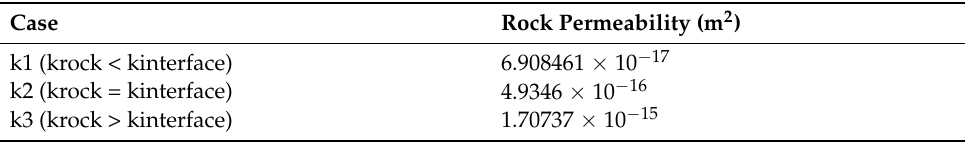
Table 3. Rock permeability values used for three cases of simulation